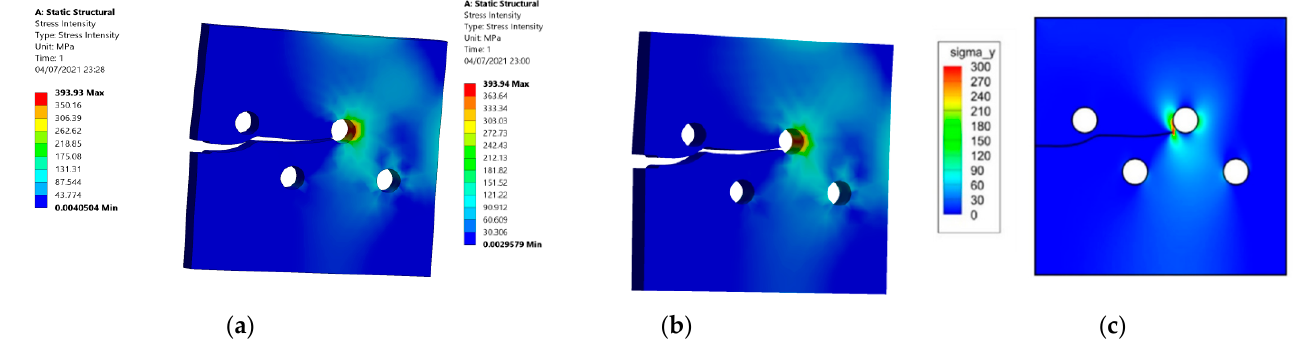
Figure 7. Stress intensity distribution: ( a ) 10 mm thickness, ( b ) 20 mm thickness, and ( c ) FMM BEM [38] .